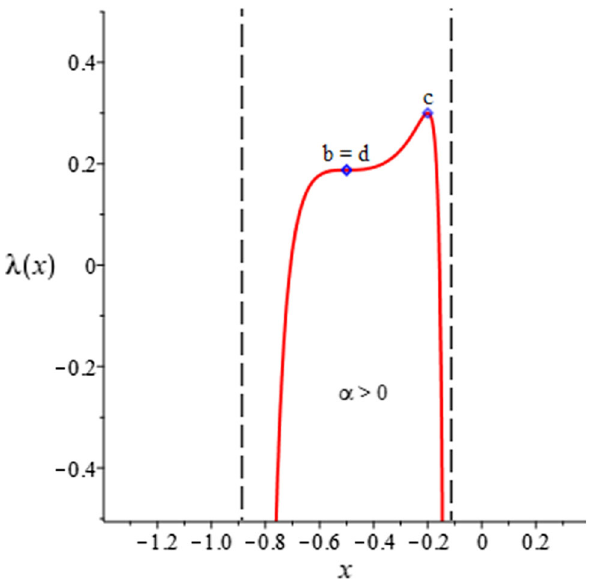
Fig. 4 The function λ( x ) = (cid:2)( x )α for α > 0, l = 6